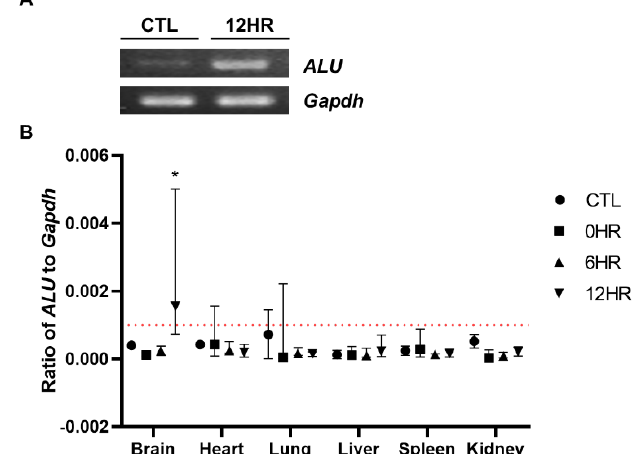
Figure 3. Quantitative assessment of the distribution of intrathecally delivered MSCs. Real-time analysis was performed using the gDNA extracts. ( A ) The human ALU sequence was successfully amplified (indicated by a white, intense band) at 12 h post-injection. ( B ) Real-time PCR analysis was performed and the ALU / Gapdh ratio was calculated. The redline is the limit of detection in this analysis. ( n = 5 / group) mean with range * p -value < 0.05 compared to the CTL of each tissue.